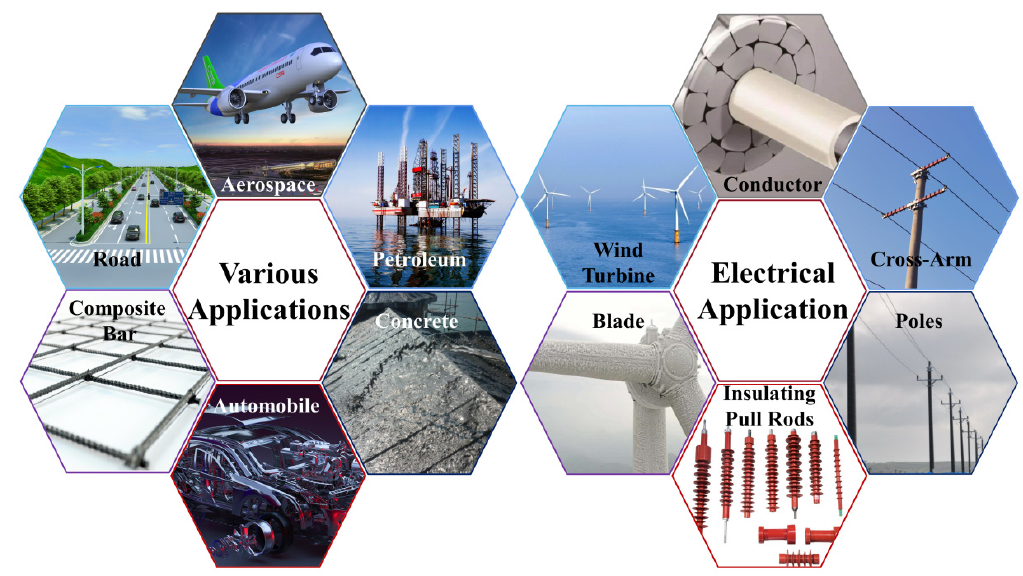
Figure 7. Application fields of BF.